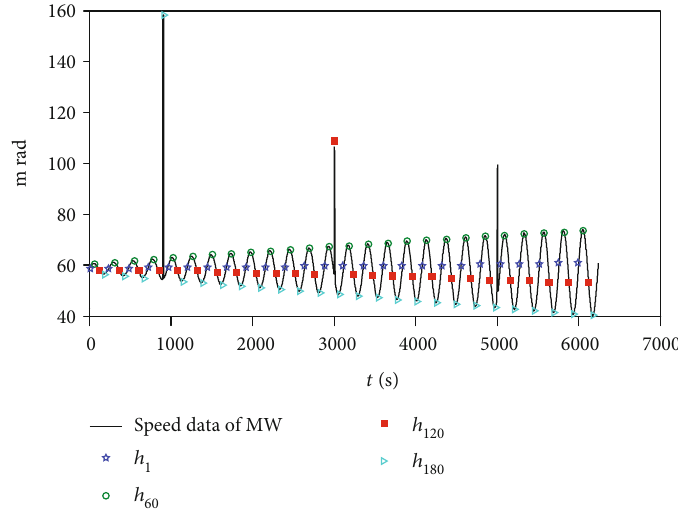
Figure 5: The curves of the selected